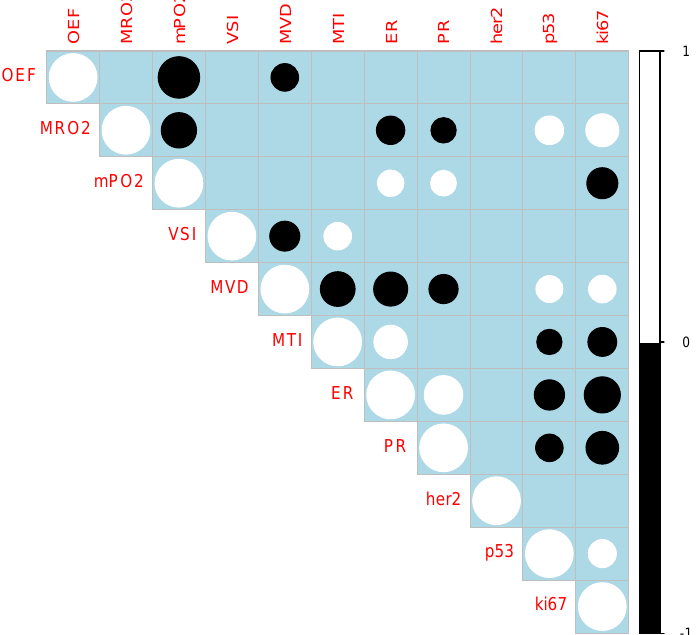
Figure 4. Correlation matrix of Spearman’s rank correlation coefficients. White indicates positive, whereas black indicates negative correlations. Size corresponds to strength of correlation. All fields with an entry were statistically significant ( p < 0.05).